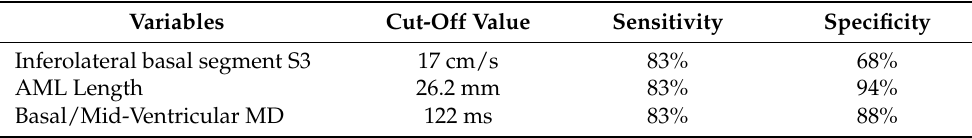
Figure 6. Youden’s Index of the inferolateral basal segment S3 velocity ROC Curve. The cut-off values matching the best sensitivity and specificity for each variable are shown in Table 5. Table 5. Sensitivity and specificity of the best cut-off values identified for each predictor. Variables Cut-Off Value Sensitivity